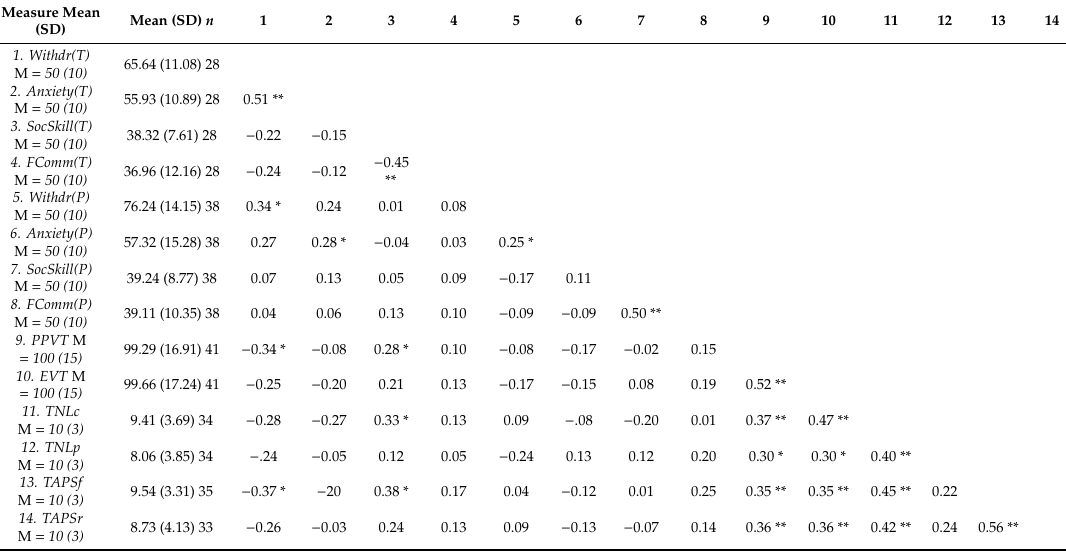
Table 5. Kendall’s tau-b Correlations of BASC-3 Adaptive Skills Composite Scale as Rated by Teachers (T) and Parents (P) and Standardized Language